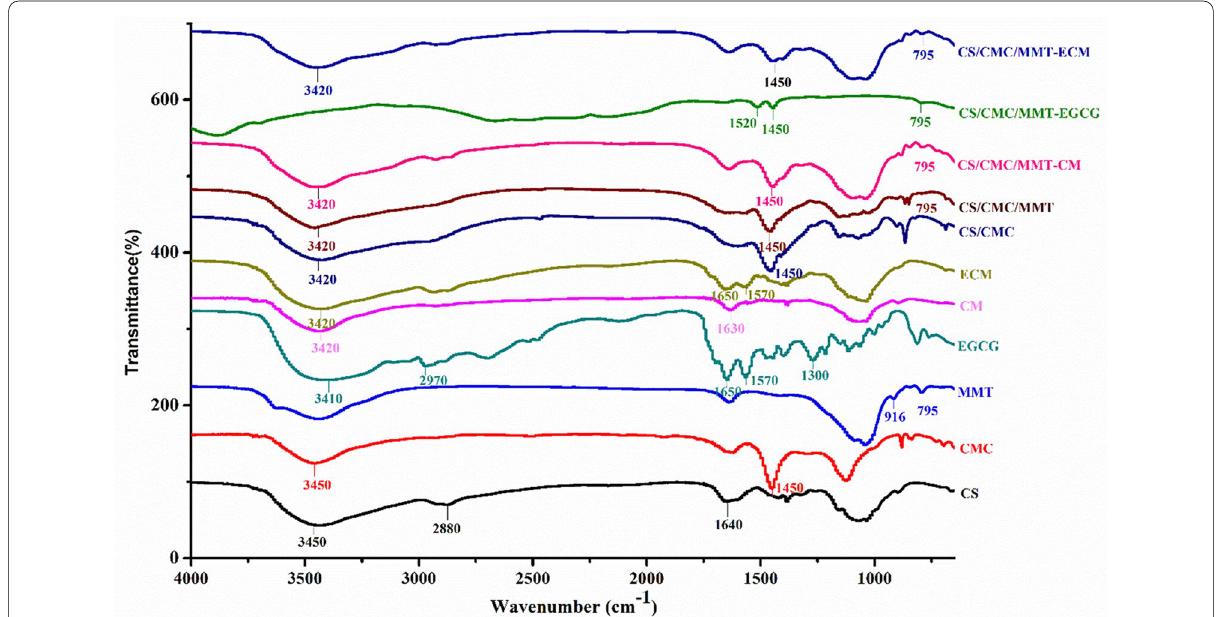
Fig. 3 FT‑IR spectra of CS, CMC, MMT, EGCG, CM, ECM, CS/CMC/MMT, CS/CMC/MMT‑CM, CS/CMC/MMT‑EGCG and CS/CMC/MMT‑ECM